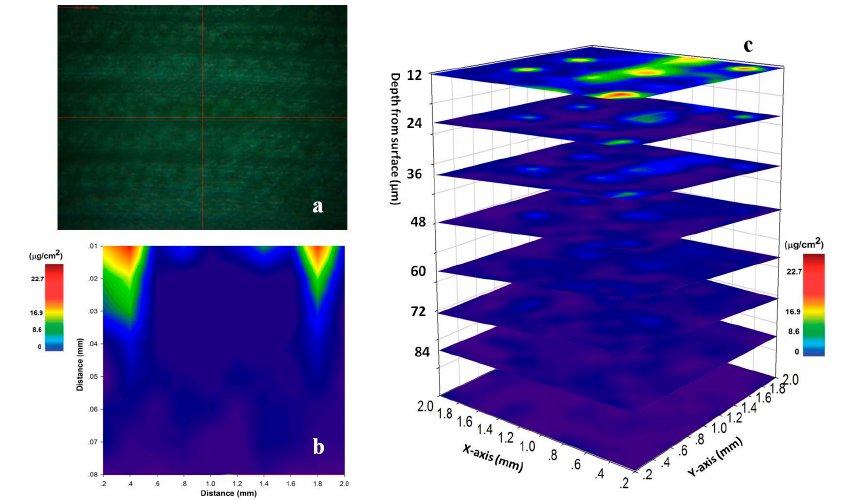
Figure 6. The 3-dimensional mapping of pesticide residues in a maize leaf 10 h after spray. ( a ) is the visible image of the scanning area observed by microscopy; ( b ) is a cross-sectional image that shows the pesticide distribution in a lateral plane; ( c ) shows the 3-dimensional image of the pesticide by scanning one plane after another, with a thickness of 12 μ m for each plane.